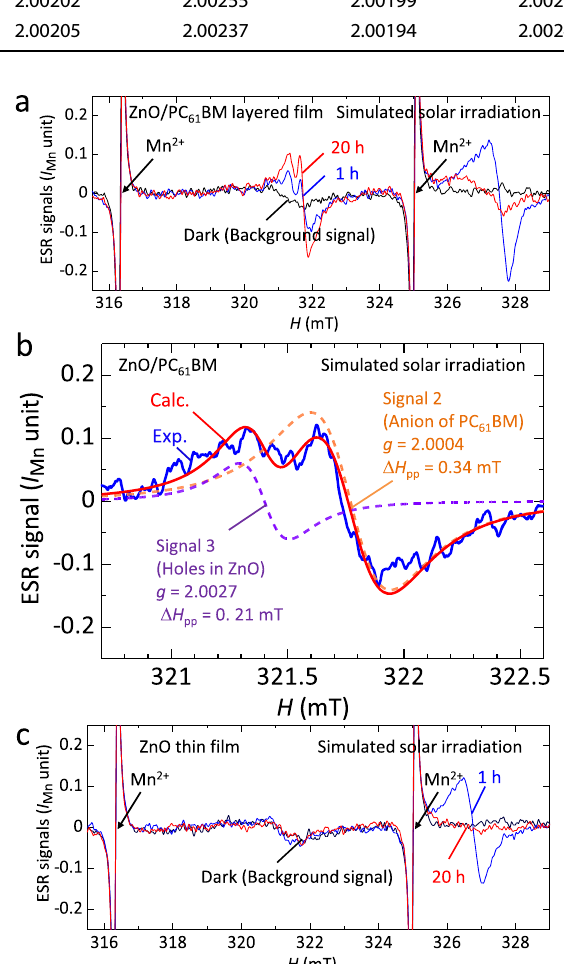
Fig. 5 ESR signals of ZnO/PC 61 BM layered fi lm and ZnO thin fi lm and fi tting analysis. a Time variation of ESR spectra of ZnO/PC 61 BM layered fi lm. b Fitting analysis for the ZnO/PC 61 BM signal in low magnetic fi elds at around 321.5 mT (Signal 2 and Signal 3). c Time variation of ESR spectra of ZnO thin fi lm in high magnetic fi elds at around 327.5 mT (Signal 4). These samples were measured with the same conditions used for the